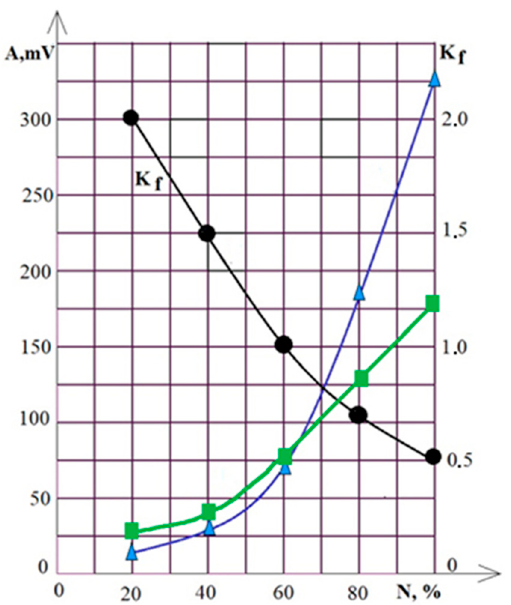
Figure 8. The change in the average square value of the VA signal amplitude in the octave bands 8 kHz (green) and 16 kHz (blue) and their ratio Kf (black) with changes in the power output N% of laser pulses.